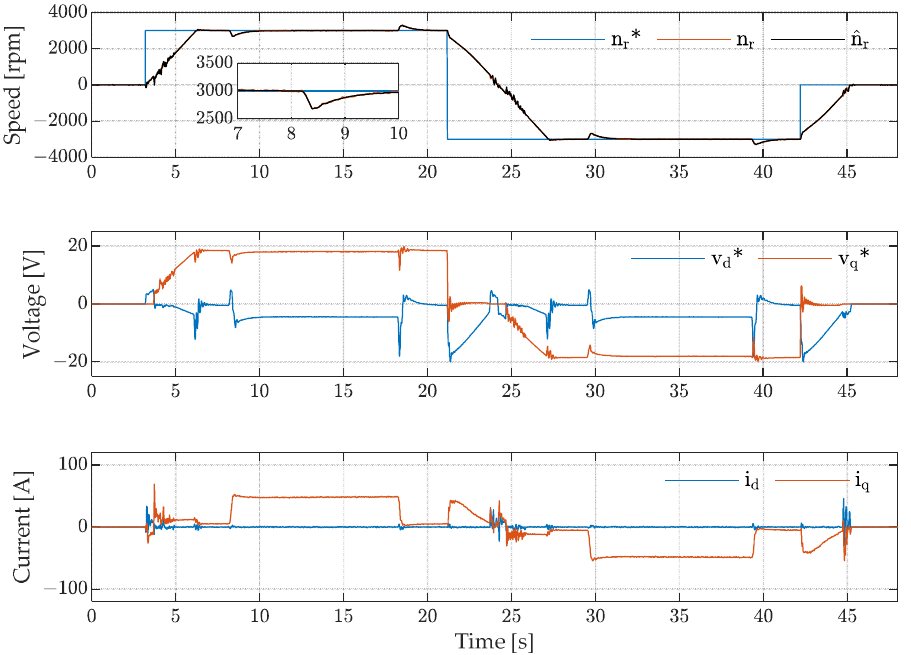
Figure 29. Ramp-up and ramp-down with the nominal reference speed and 75% load applied at steady-state: speed, dq voltages, dq currents.